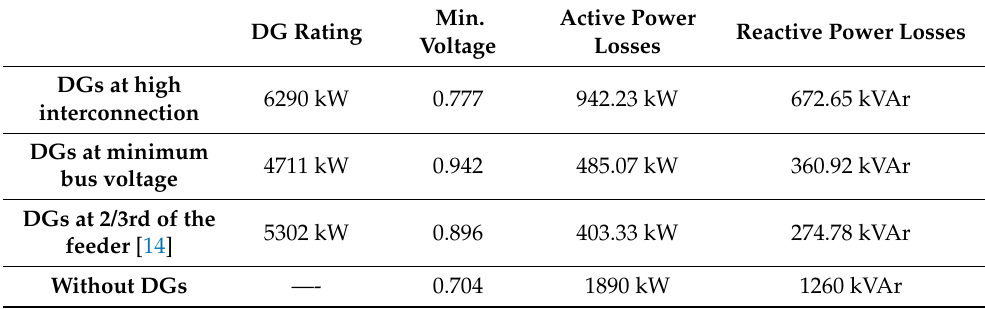
Figure 11. The voltage profile at 200% loading condition. Table 9. Summary of the load flow results at 250% loading, or a total connected load of (8952 + j4362.5) kVA.